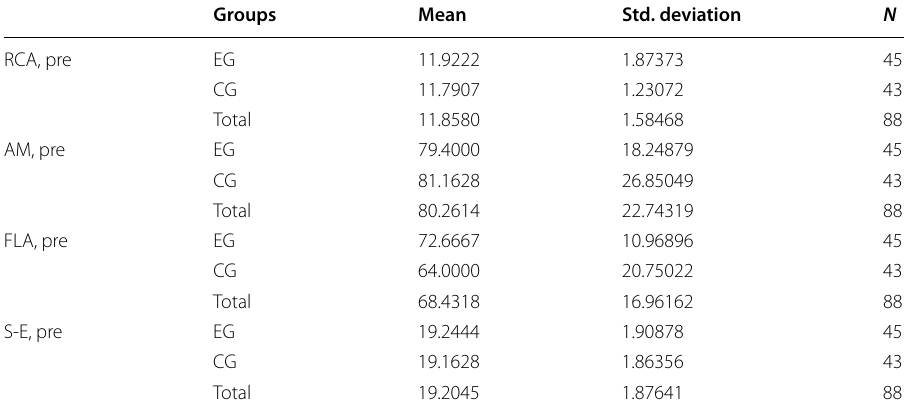
Table 1 Descriptive statistics results comparing EG and CG on RCA, AM, FLA, and S-E scores of the pretest Groups